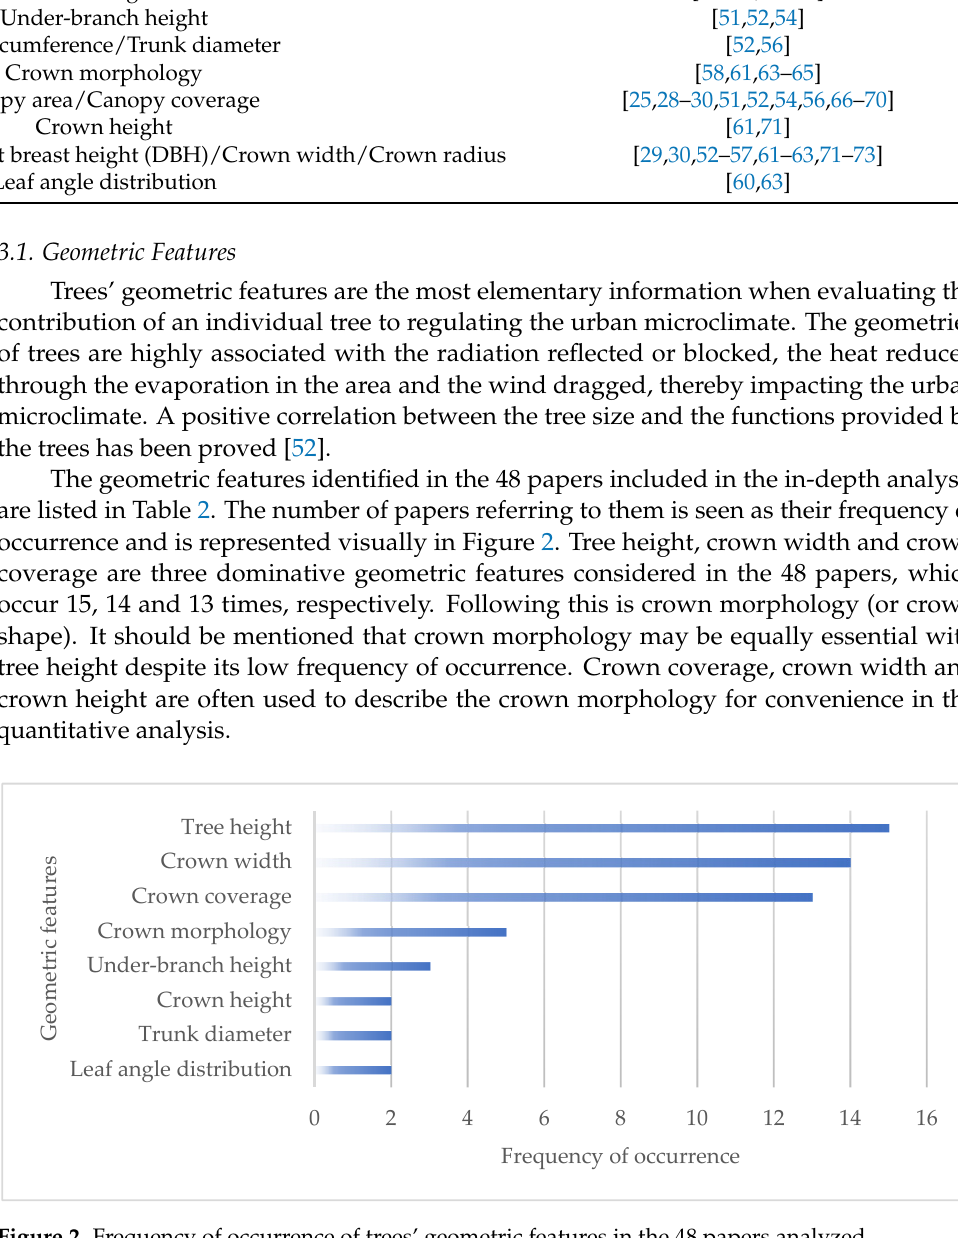
Figure 2. Frequency of occurrence of trees’ geometric features in the 48 papers analyzed. Table 2. Geometric features of trees summarized from the literature.